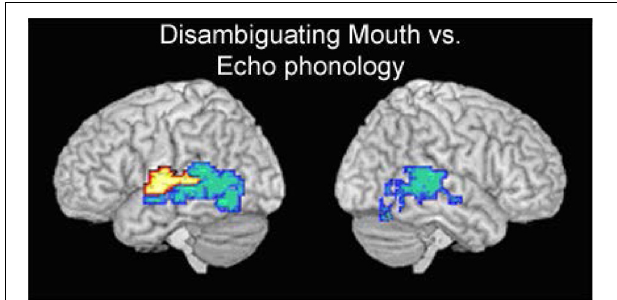
FIGURE 5 | Contrast between activation for DM (yellow) and EP signs